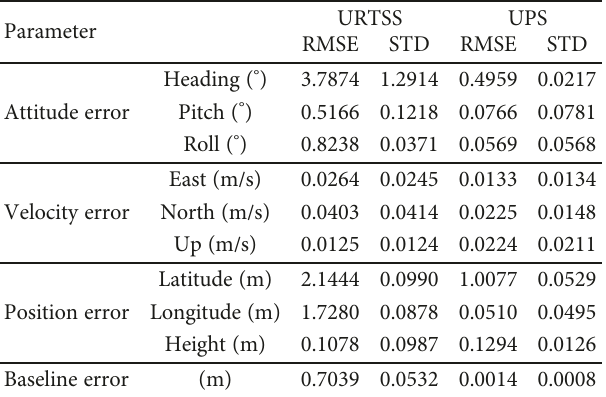
Table 1: Means of RMSE and STD values of estimate errors. Parameter